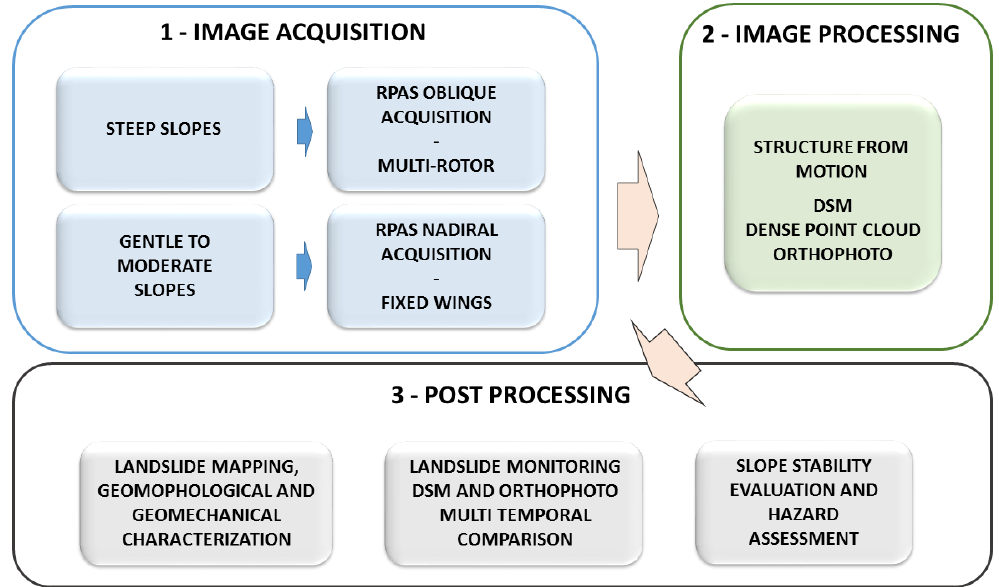
Figure 4. Acquisition, processing and post-processing of RPAS images applied to (i) landslide recognition, (ii) hazard assessment and (iii) slope evolution